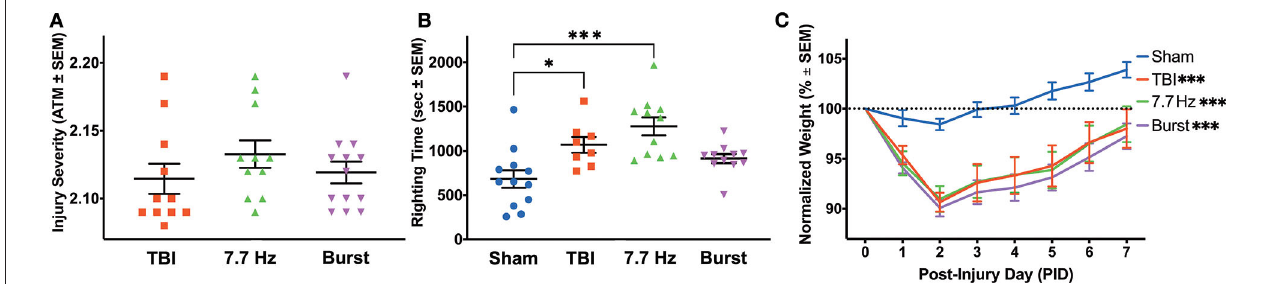
FIGURE 2 | Injured Animals had Impaired Recovery from Surgery, Regardless of Treatment Group. (A) Peak atmospheric pressure was used as a measure of injury severity to counterbalance TBI animals into treatment groups. (B) There were significant differences between groups in righting time following surgery. The TBI and 7.7Hz groups had significantly elevated righting times compared to sham (Sham vs. TBI: p < 0.05; Sham vs. 7.7 Hz: p < 0.001). (C) All injury groups had a significantly larger weight loss following injury compared to sham ( p < 0.001), and there were effects of group and time, as well as an interaction between the two, on recovery in the week following surgery. All data are presented as mean ± SEM, * p < 0.05, *** p < 0.001. Adapted from Paxinos et al.